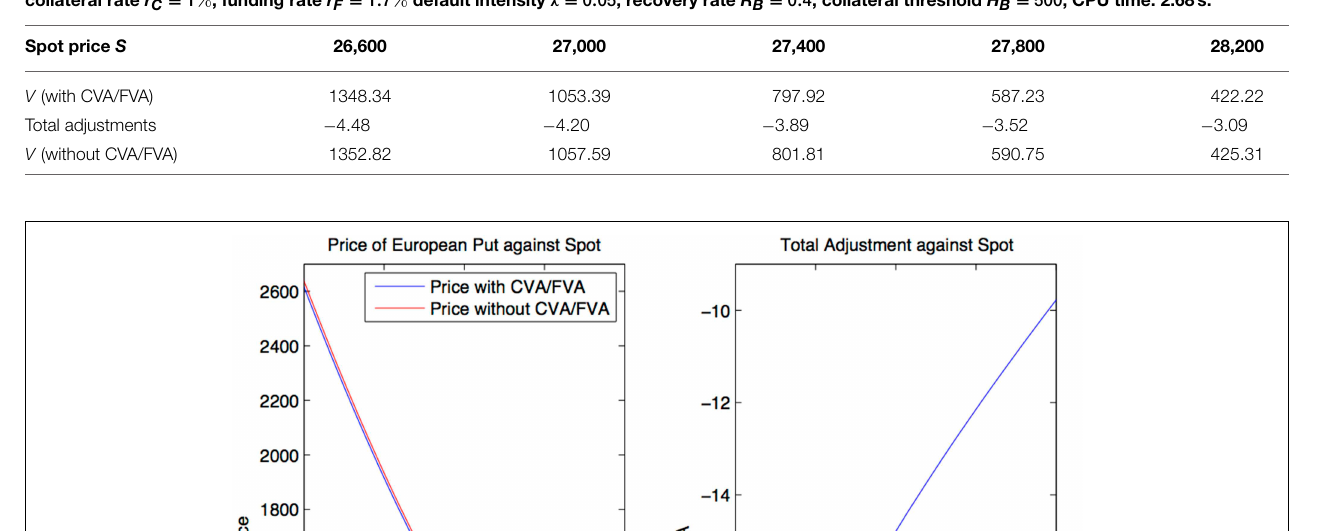
TABLE 4 | Prices of European put under KoBoL process as of 28 May 2015, time to maturity T = 0 . 0877 , strike K = 27 , 400 , risk-free rate r = 0 . 25 % , collateral rate r